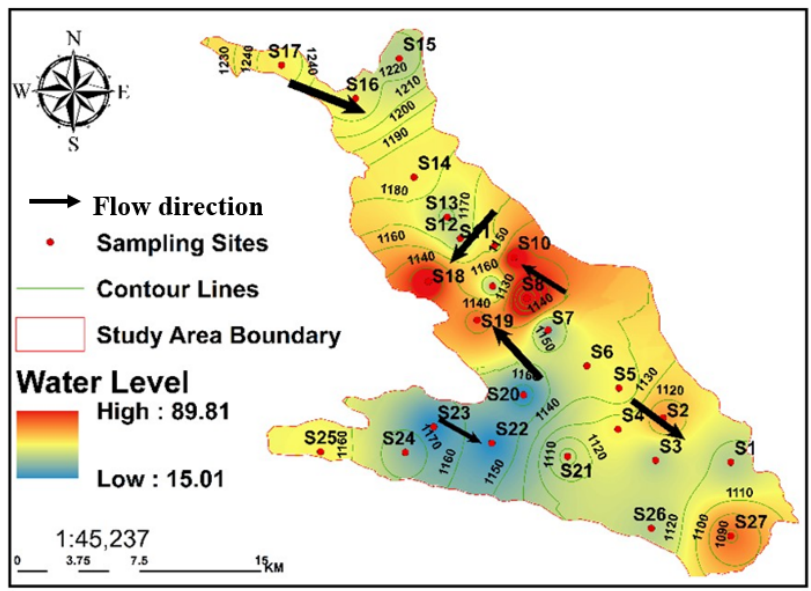
Figure 3. The Quaternary aquifer’s groundwater fl ow direction.